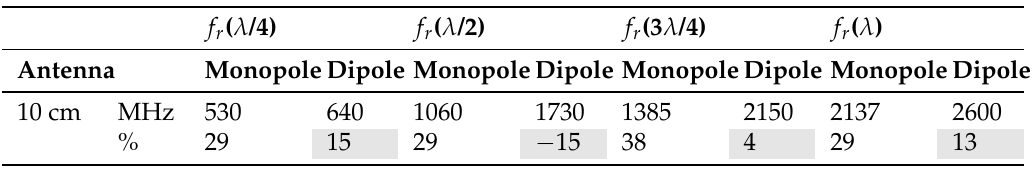
Table 2. Experimental values of the resonance frequencies of the 10 cm antenna working as dipole or monopole antenna for λ /4, λ /2, 3 λ /4 and λ .